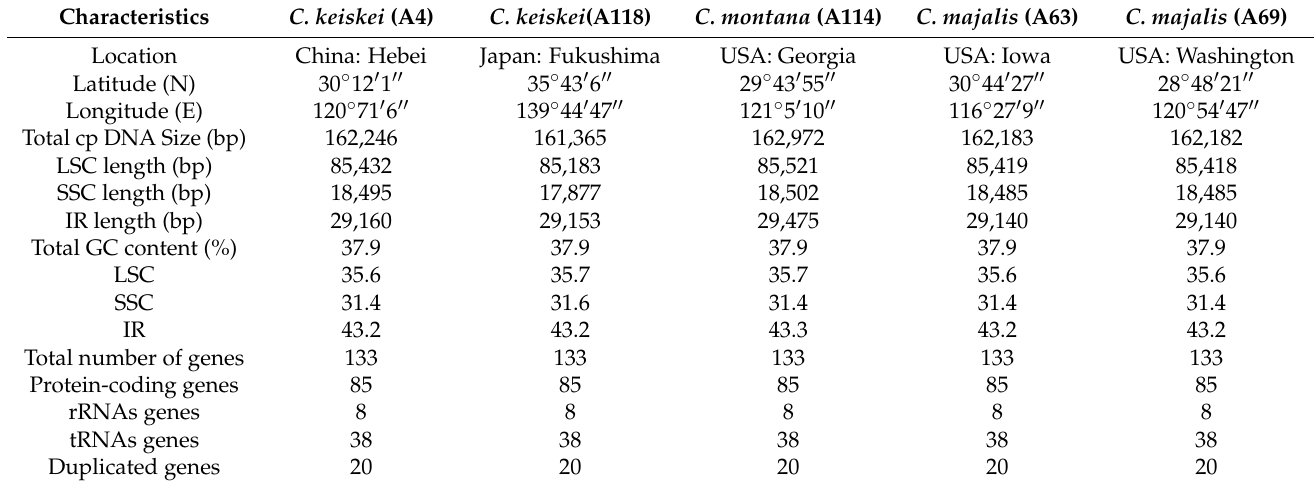
Table 1. The sample information and characteristics of Convallaria chloroplast genomes.